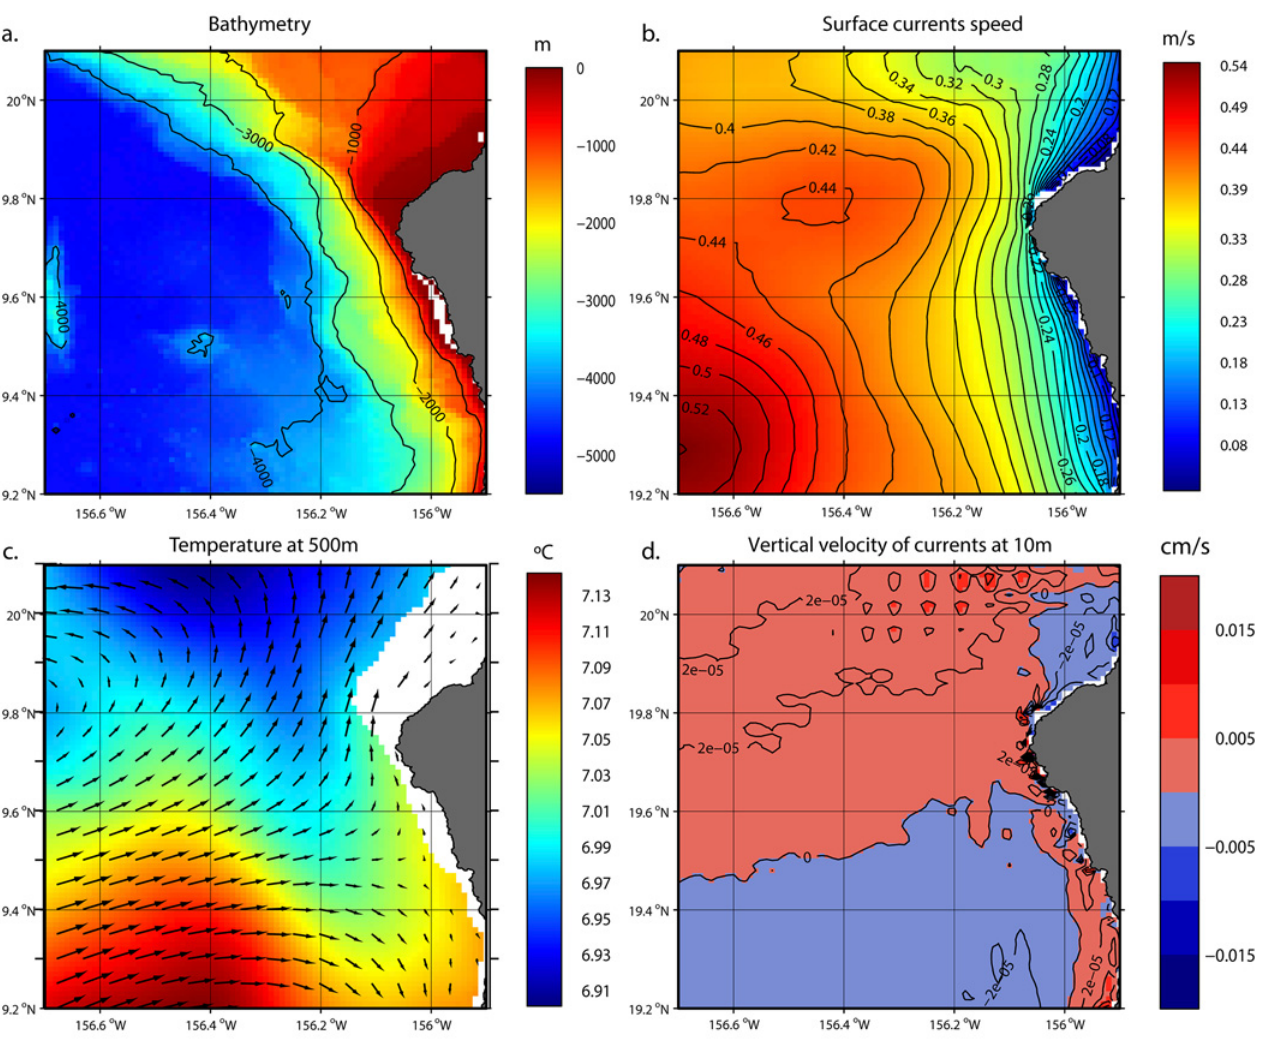
Fig 6. Kona Coast oceanography. Bathymetry (a, m), Currents speed (m/s) at the surface (b), Temperature (°C) at 500 m overlayed with surface currents vectors (c, the white area corresponds to waters shallower than 500 m) and vertical velocity (cm/s) of currents at 10 m (d). See text for data sources.